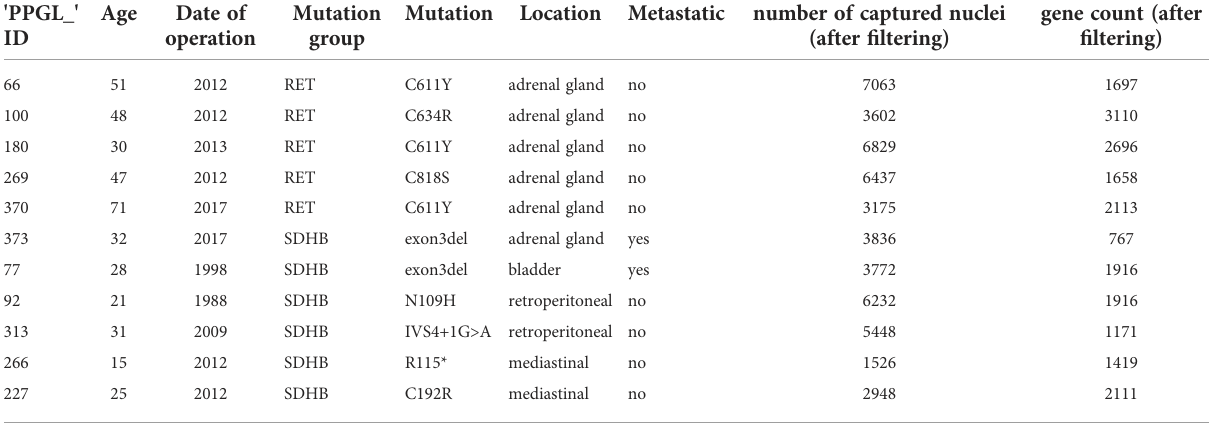
TABLE 1 Clinical information and snRNAseq quality parameters of processed/analyzed